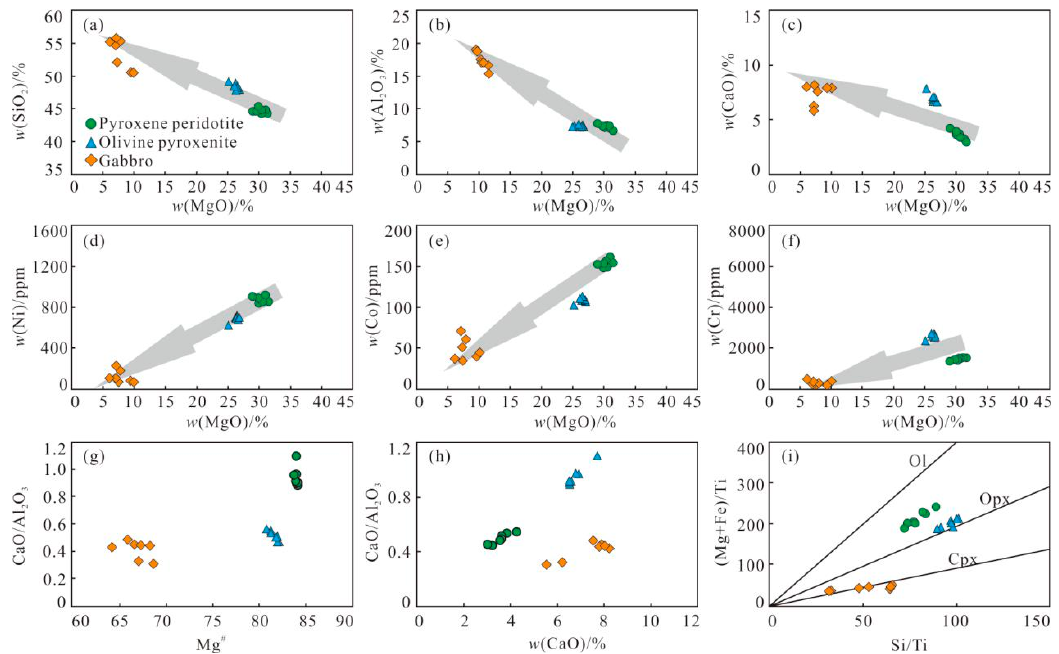
Figure 14. Geochemical diagrams of the mafic-ultramafic rocks in the Niubiziliang Ni-(Cu) deposit. ( a ) The negative correlation between MgO and SiO 2 ; ( b ) The negative correlation between MgO and Al 2 O 3 ; ( c ) The negative correlation between MgO and CaO; ( d ) The positive correlation between MgO and Ni; ( e ) The positive correlation between MgO and Co; ( f ) The positive correlation between MgO and Cr; ( g ) The discrete relationship between Mg # and CaO/Al 2 O 3 ; ( h ) The discrete relationship between CaO and CaO/Al 2 O 3 ; ( i ) The crystallizations of clinopyroxene and orthopyroxene.